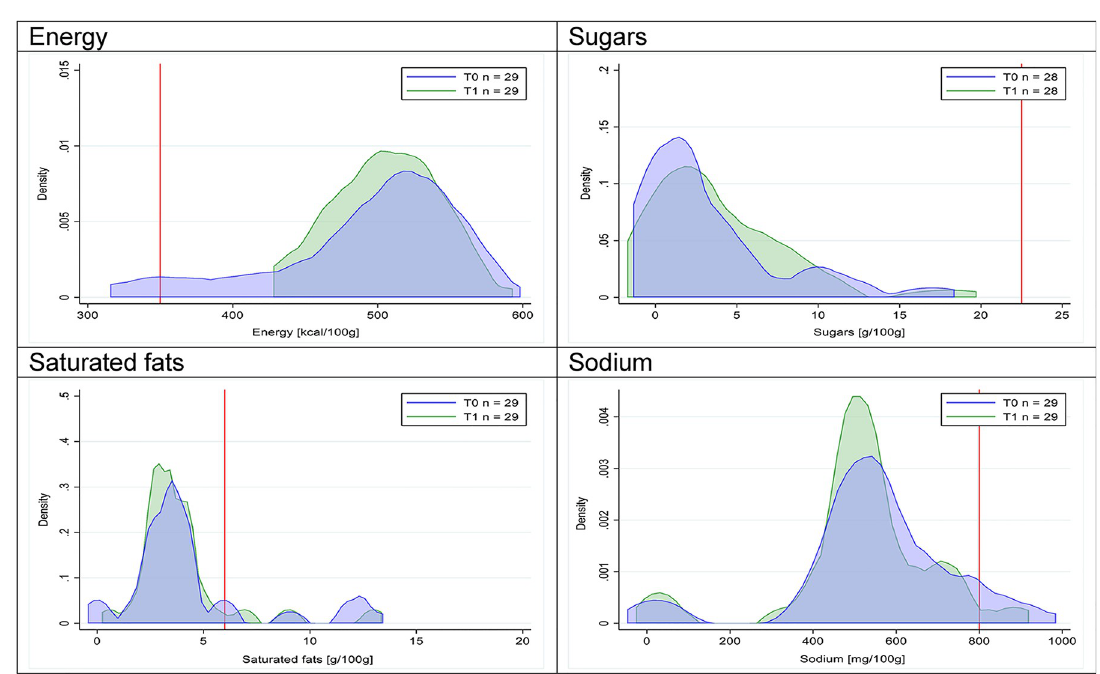
Fig 27. Density curves for the amount of energy and nutrients of concern in savory snacks, longitudinal subsample. The blue line represents the distribution in T0 (preimplementation), the green line represents the distribution in T1 (postimplementation), and the red line represents the cutoff for the amount of energy or nutrients of concern.